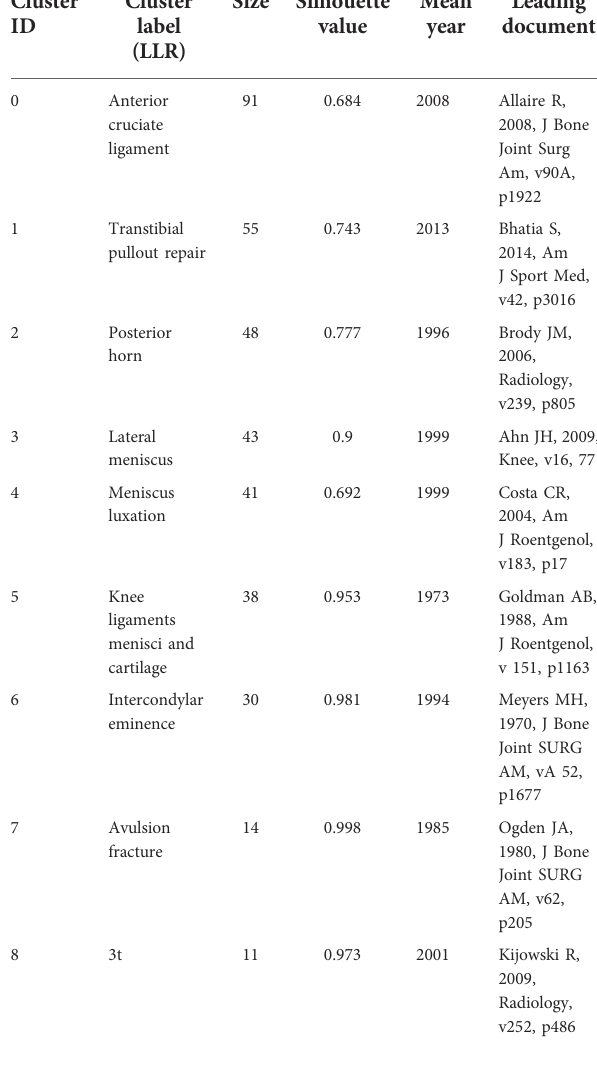
TABLE 7 The signi fi cant clusters of co-citation of